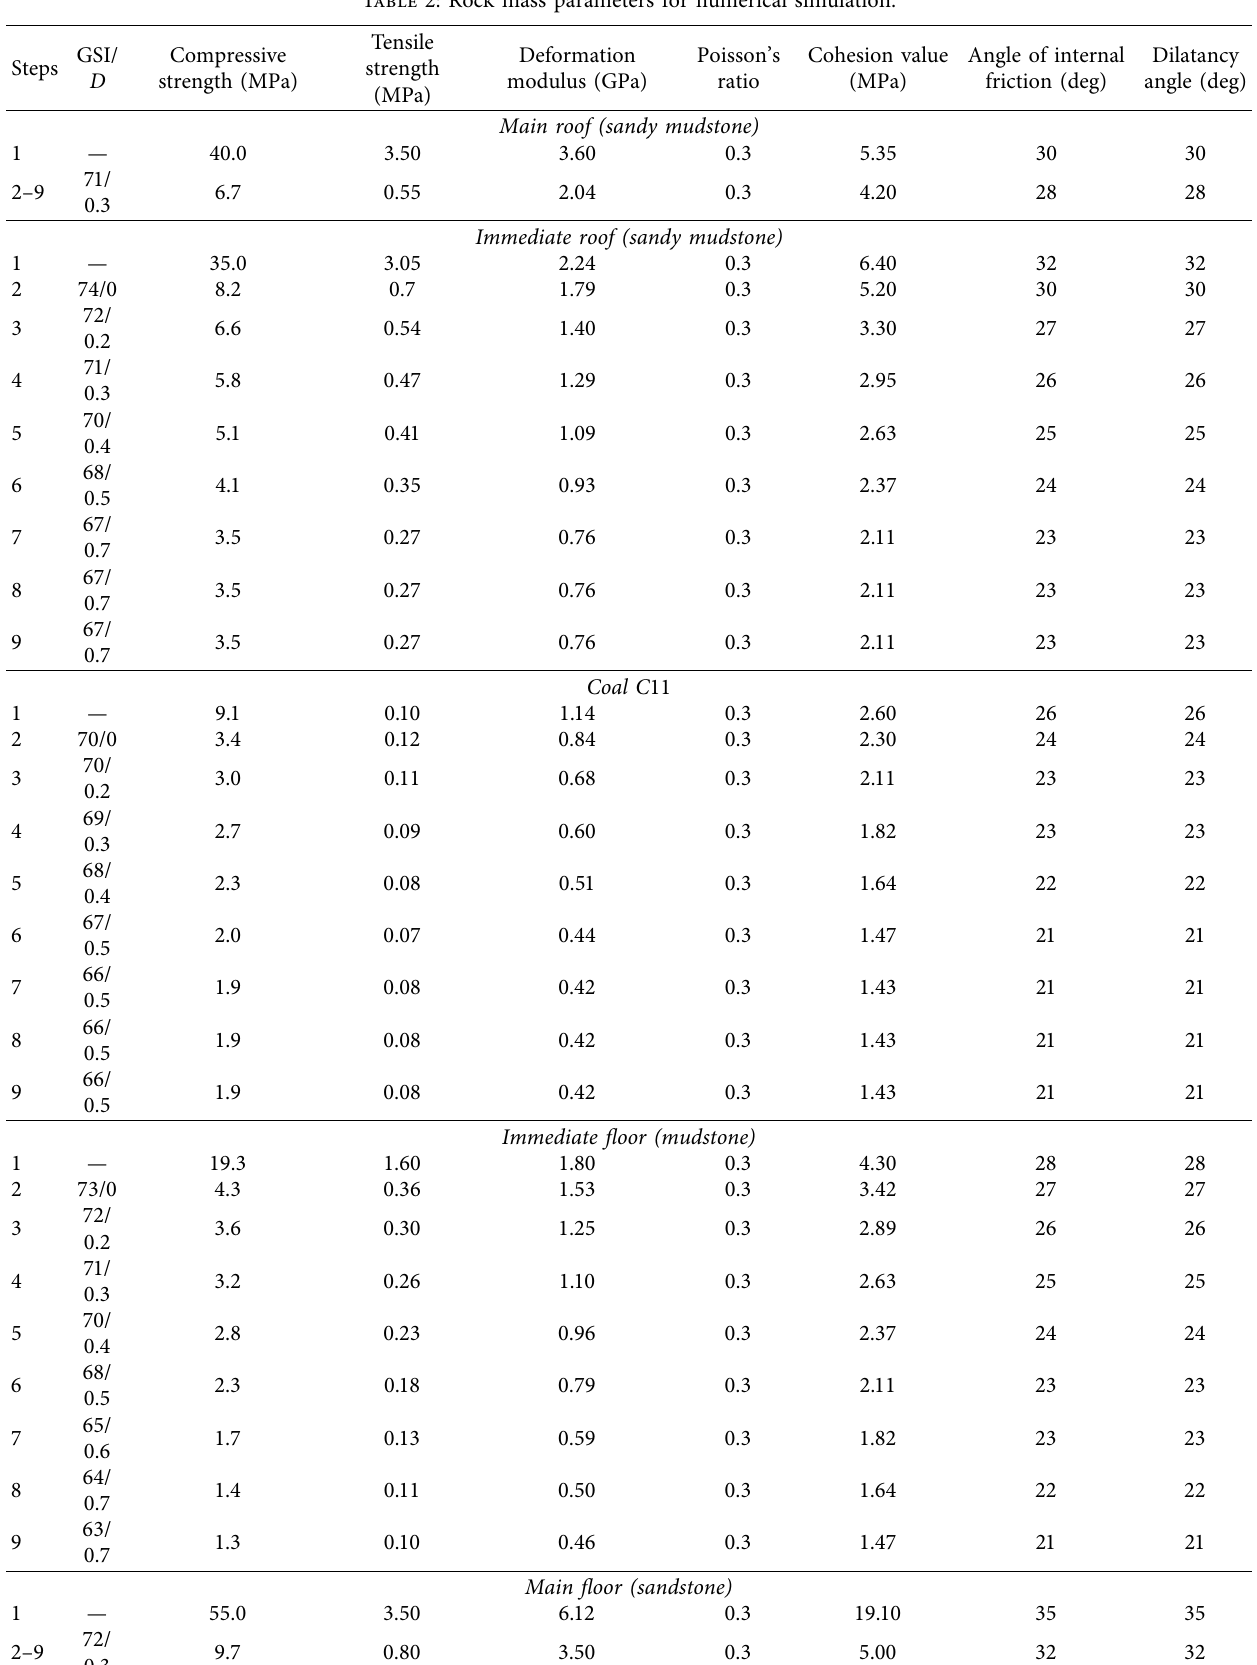
Table 2: Rock mass parameters for numerical